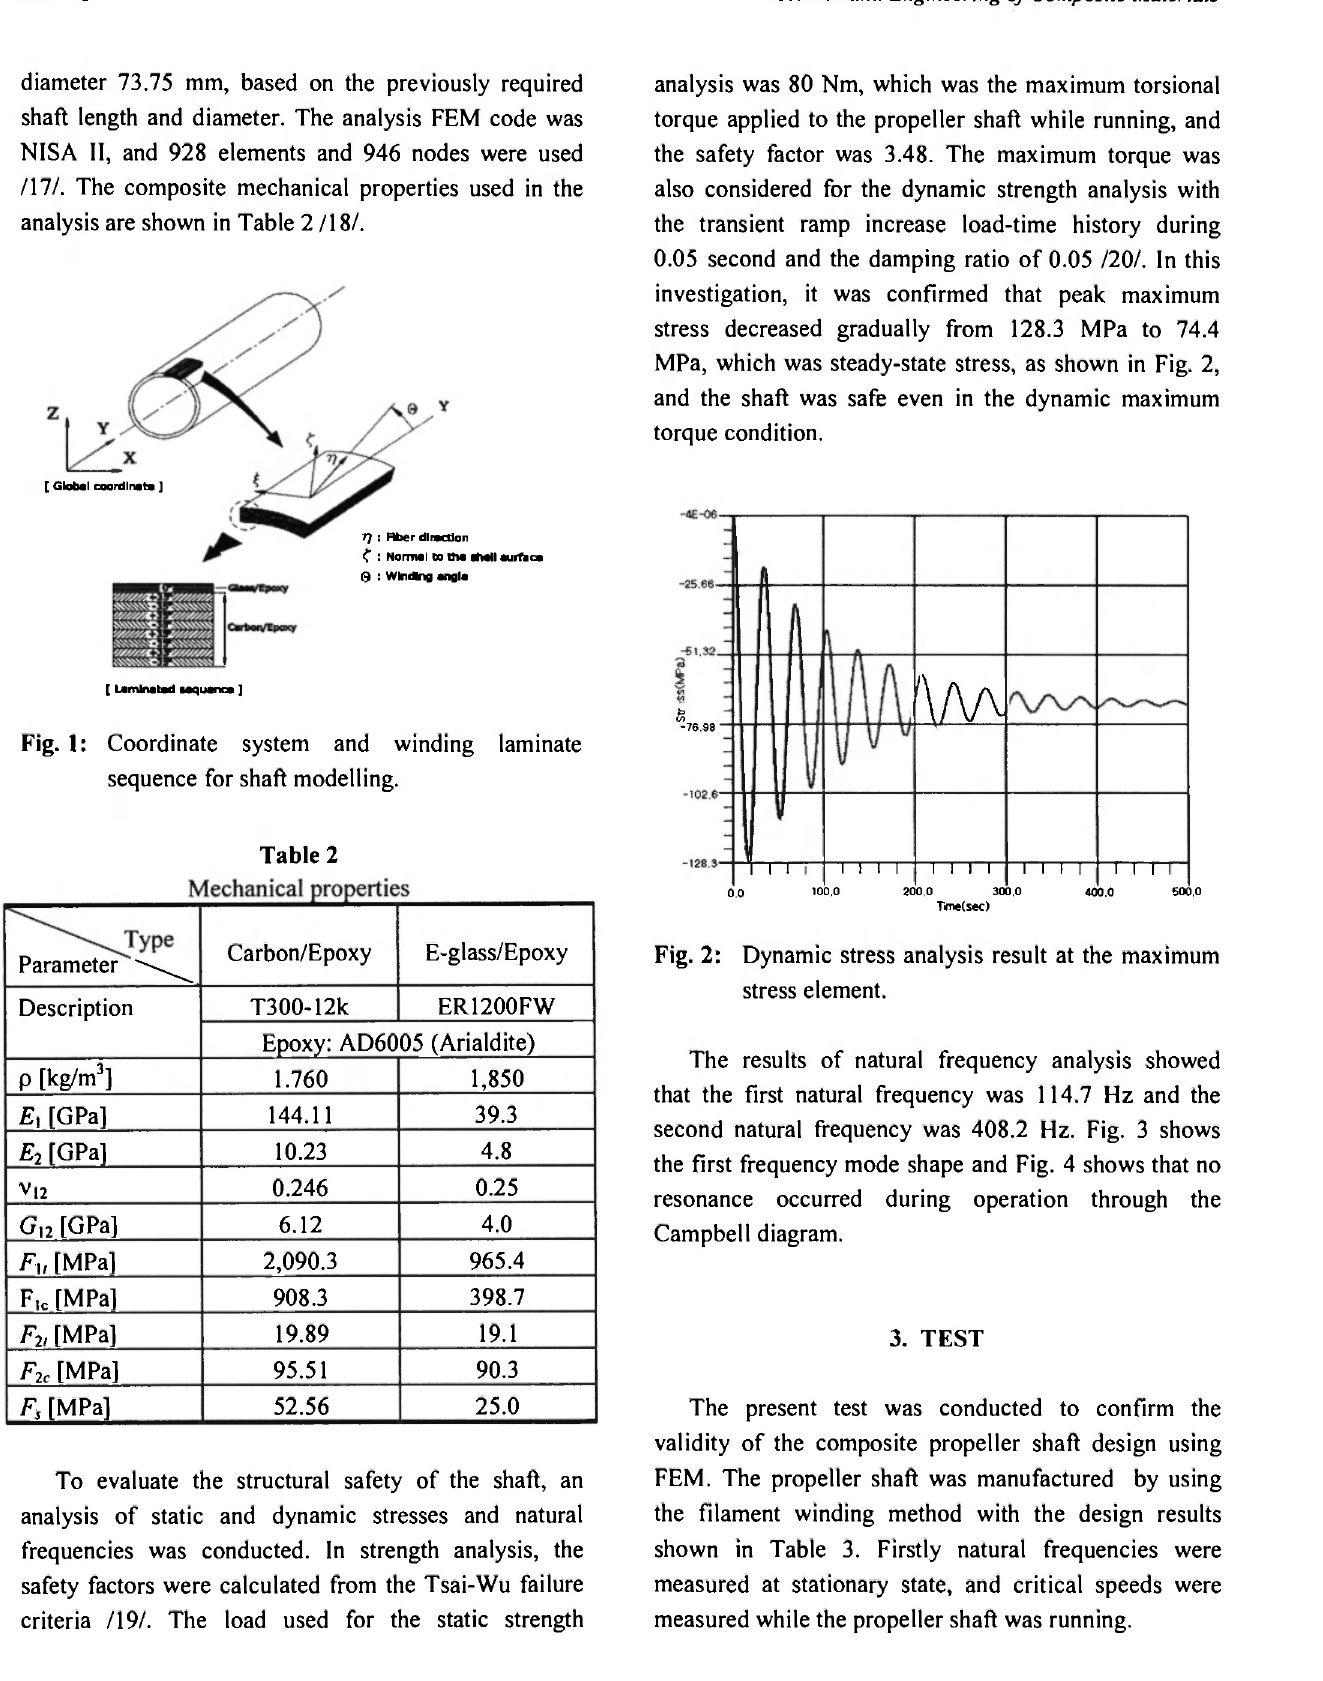
Fig. 2: Dynamic stress analysis result at the maximum stress